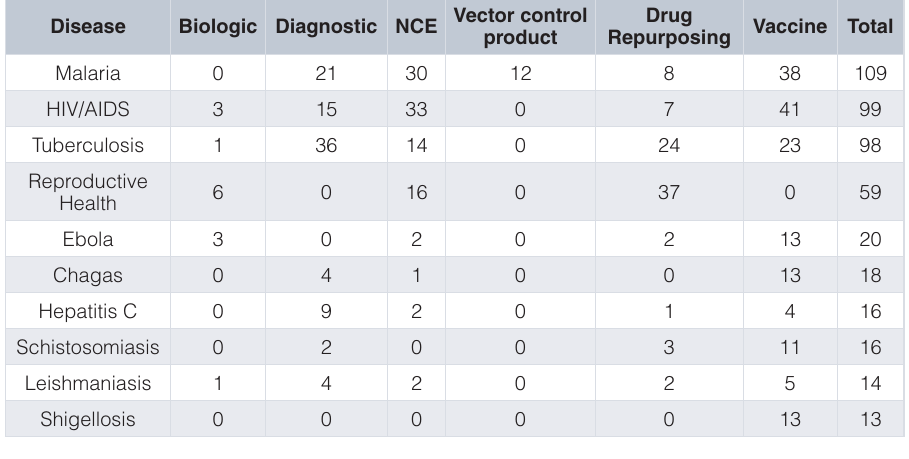
Table 6. Breakdown of candidates by disease and archetype for the 10 diseases/conditions that have the most candidates in the pipeline.